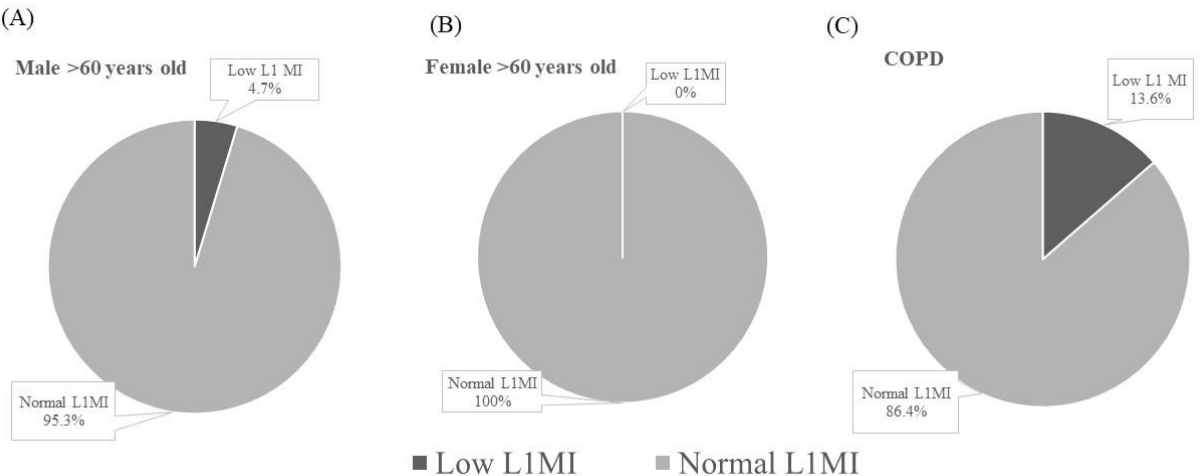
Figure 2. Proportion of low L1MI: ( A ) males aged more than 60 years; ( B ) females aged more than 60 years; ( C ) COPD. Abbreviation: L1MI: the ratio of muscle surface (cm 2 ) at L1 to height (meters) squared; COPD: chronic obstructive pulmonary disease.